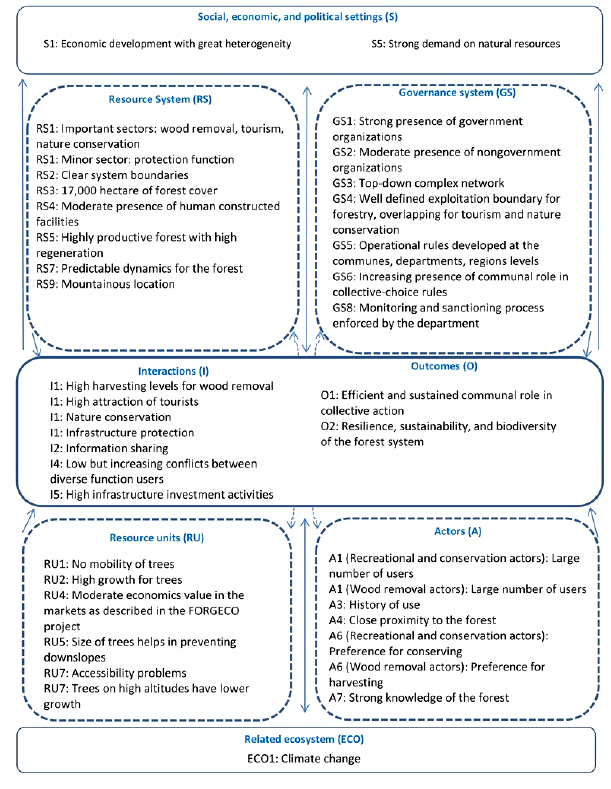
Fig. 3 . The modified SES framework for the Quatre-Montagnes case study. Solid boxes denote first-tier categories; resource systems, governance systems, resource units, and actors are the highest-tier variables (they contain multiple variables at the lower tiers). All the actions take place as inputs and transform into outcomes in the action situations. Dashed arrows denote feedback from the action situations to each of the top-tier categories. Exogenous influences from related ecological systems or social-economic-political settings can affect any component of the SES. We only outlined variables that we found relevant to our case study through our identification method. For a more detailed view on the data and assessment method, see Appendix